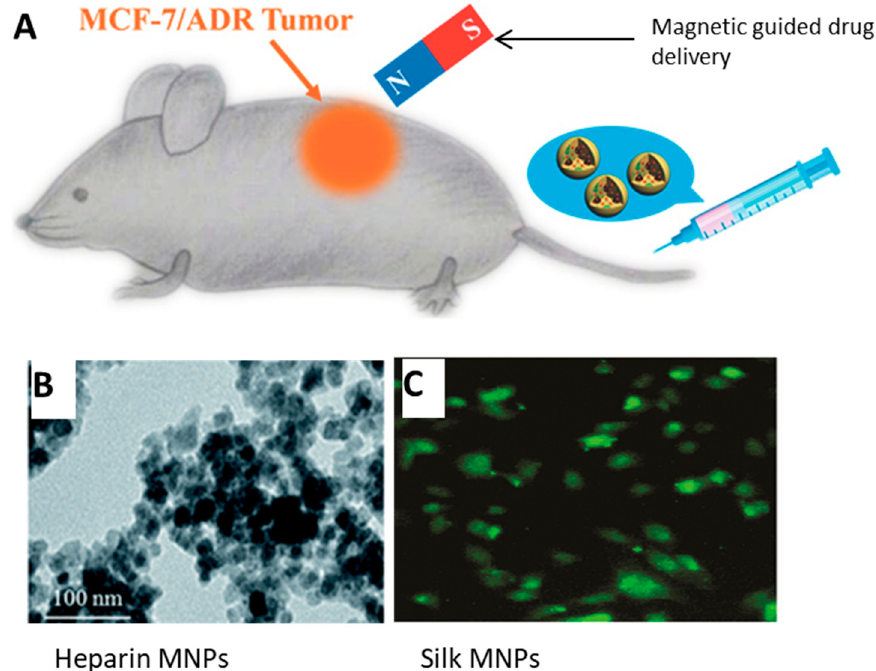
Figure 8. Drug delivery uses of magnetic nanoparticles and protein / polysaccharide materials. ( A ) The full drug delivery system used by Tian et al. that shows the combination of MNPs and silk protein. ( B ) Images of a heparin-coated iron-oxide magnetic nanocomposite (Scale: 100 nm). ( C ) Composite of MNPs and silk to deliver curcumin. (Reproduced with permission from Refs [80,162,163] ( A ) Copyright ACS, 2017; ( B ) John Wiley and Sons, 2014; ( C ) RSC Publishing,